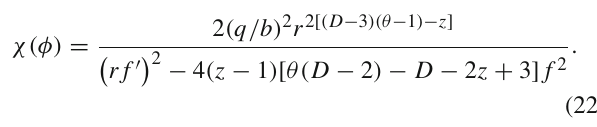
Table 1 We show the special values and regions in the parameter space where the field equations display a different branch of solution